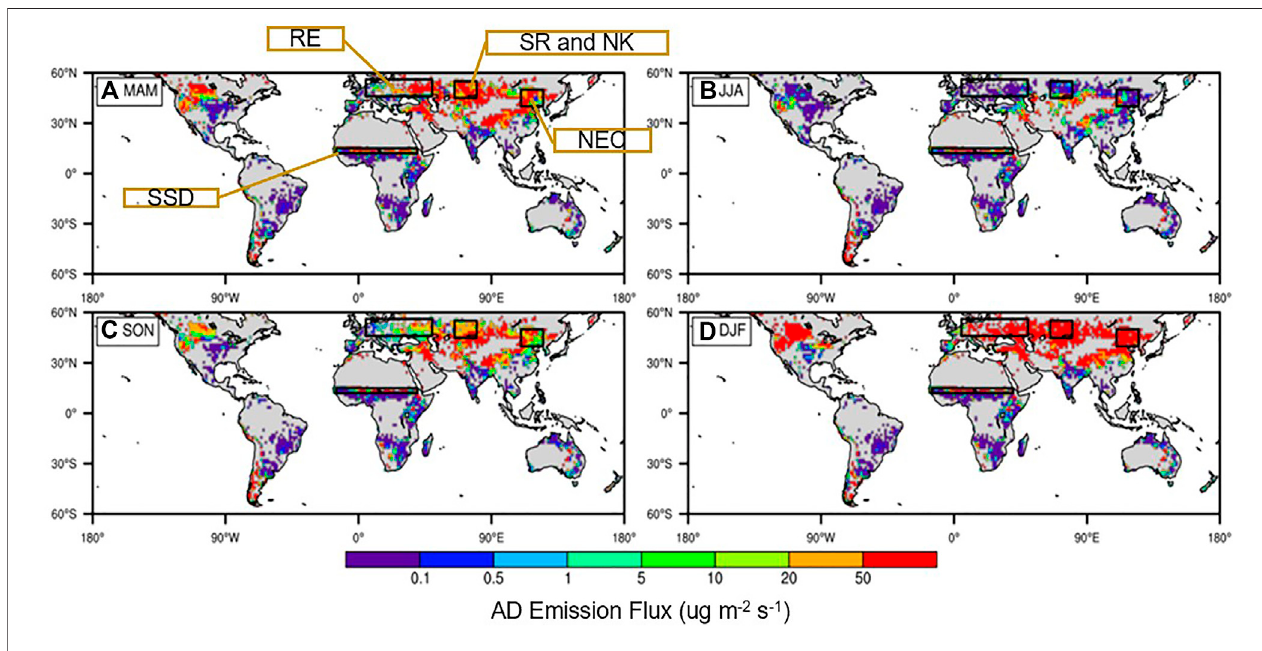
FIGURE 6 | Same as Figure 5 of AD emission fl uxes.